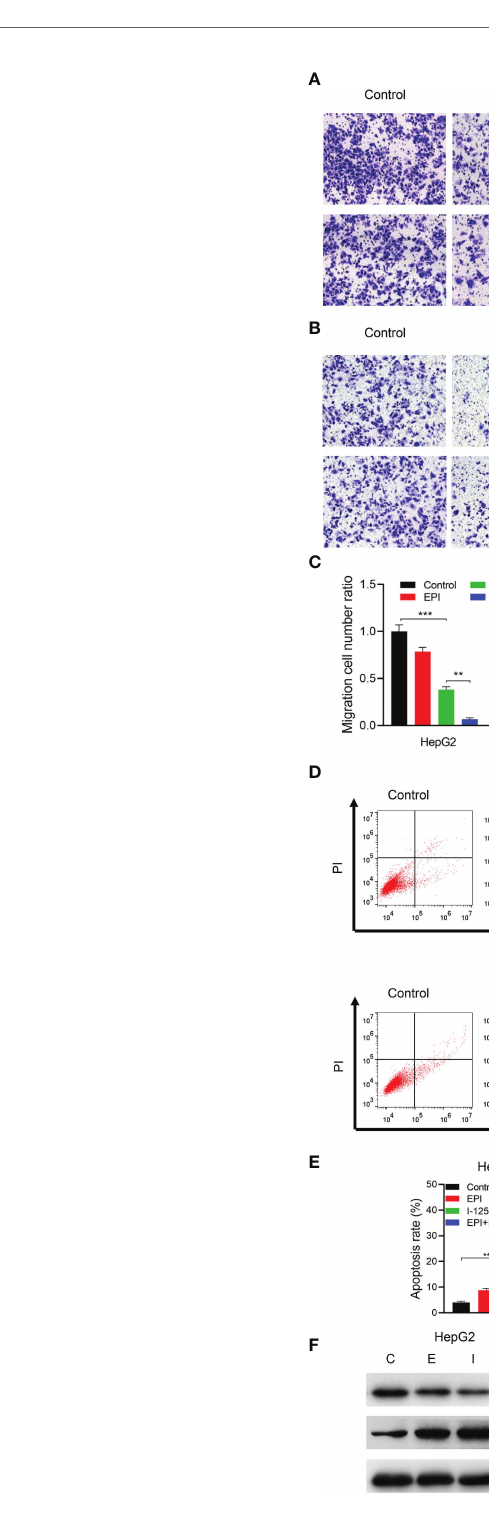
FIGURE 2 | EPI enhances the inhibition effect of 125 I on cell migration and invasion and induction of cell apoptosis. (A – C) Transwell assays showing the effect of EPI in promoting 125 I-induced inhibition of migration and invasion of HCC cells. (D, E) Flow cytometry showing the combined effect of EPI and 125 I. (F) Western blot showing the Bcl2/Bax ratio. All experiments were performed in triplicate, and the data are presented as the mean ± SD. * P < 0.05, ** P < 0.01, *** P < 0.001. HCC, hepatocellular carcinoma cells; EPI, epirubicin; Bcl2, Bcl2 apoptosis regulator; Bax, Bcl2 associated